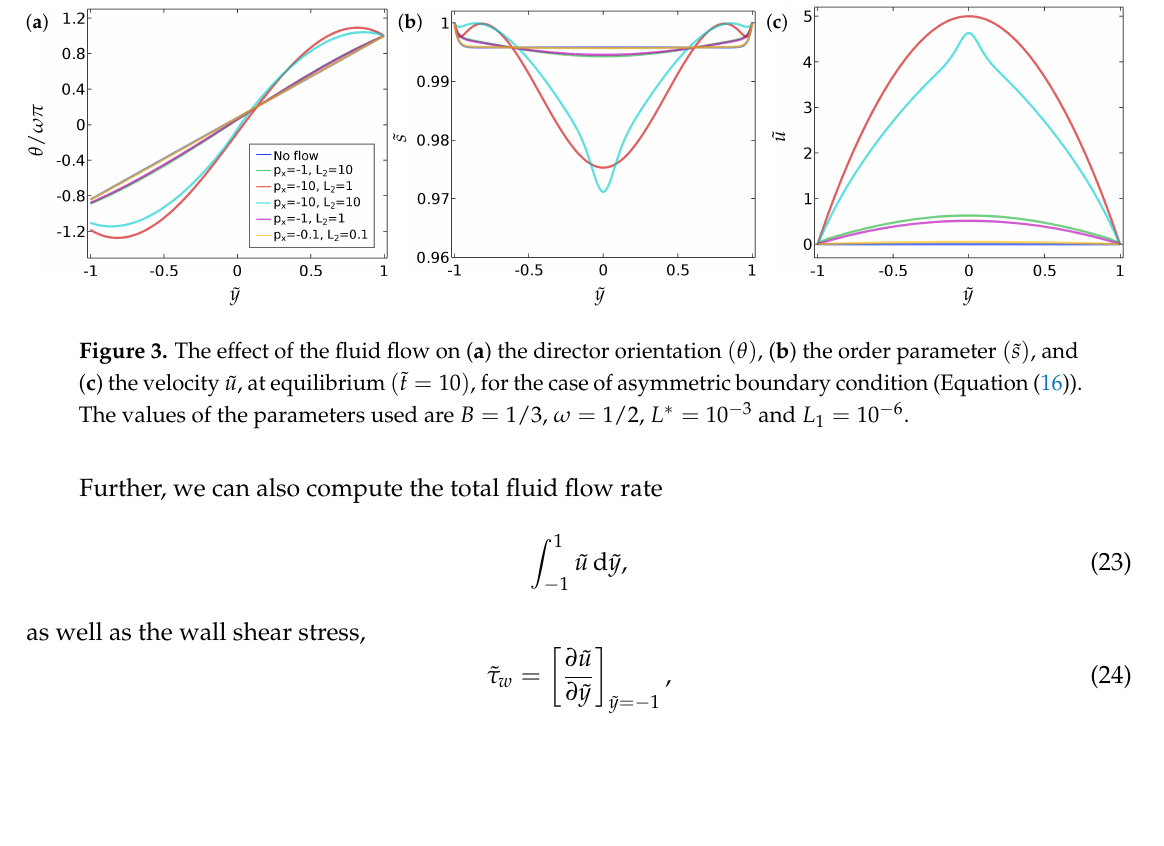
Figure 2. The effect of the fluid flow on ( a ) the director orientation ( θ ) , ( b ) the order parameter ( ˜ s ) , and ( c ) the velocity ( ˜ u ), at equilibrium, for the case of symmetric boundary condition (Equation (15)). The values of the parameters used are ω = 1/2, L ∗ = 10 − 3 and L 1 = 10 − 6 . (Here, and elsewhere, we plot the profiles at ˜ t = 10, after which time we find the solutions have relaxed to a steady state from the initial configuration, Equations (18)–(20).) Analytic solutions are given in Sections 4 and 4.1.